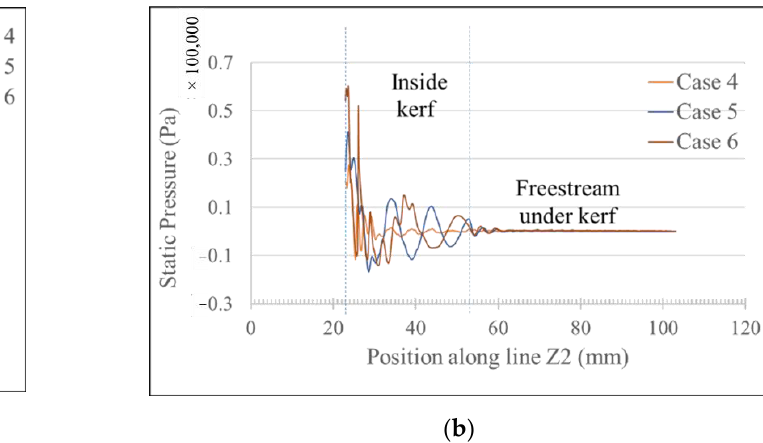
Figure 12. Pressure distribution curve for various nozzle configurations in kerf slot (l offset = 3 mm): ( a ) along line Z1 and ( b ) along line Z2.